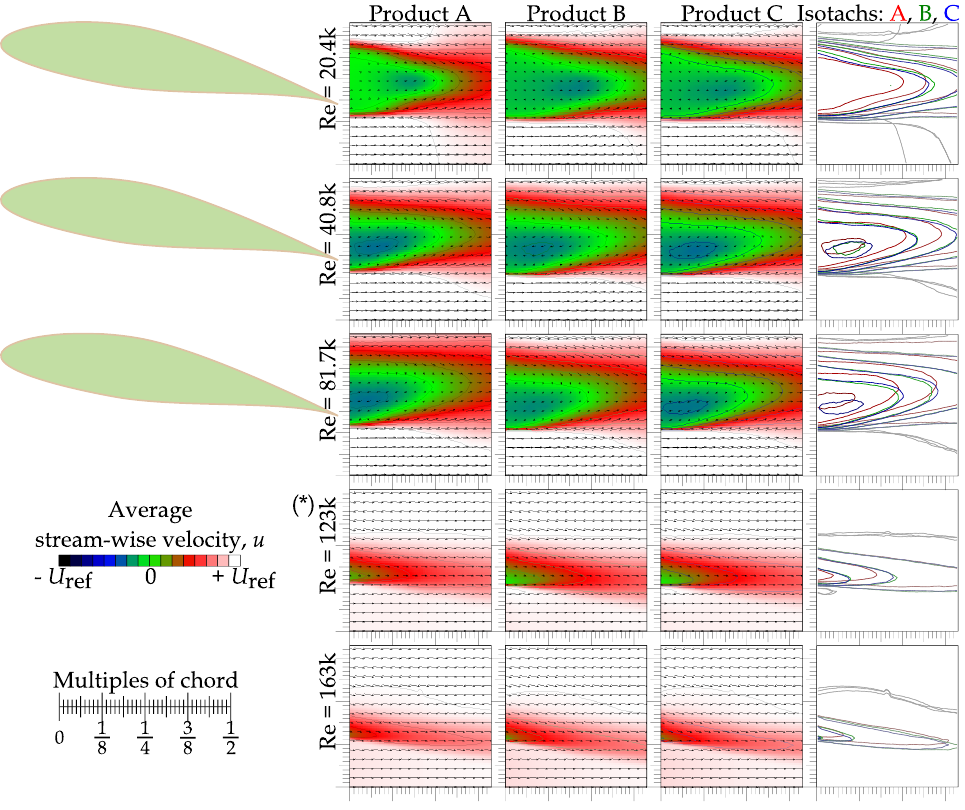
Figure A1. Map of ensemble average of stream-wise velocity u at angle of attack α = 10 ◦ . In respect to Figure 4, here is an added row denoted (*) containing data at Re = 1.23 × 10 5 in order to show that the flow is adhered at this